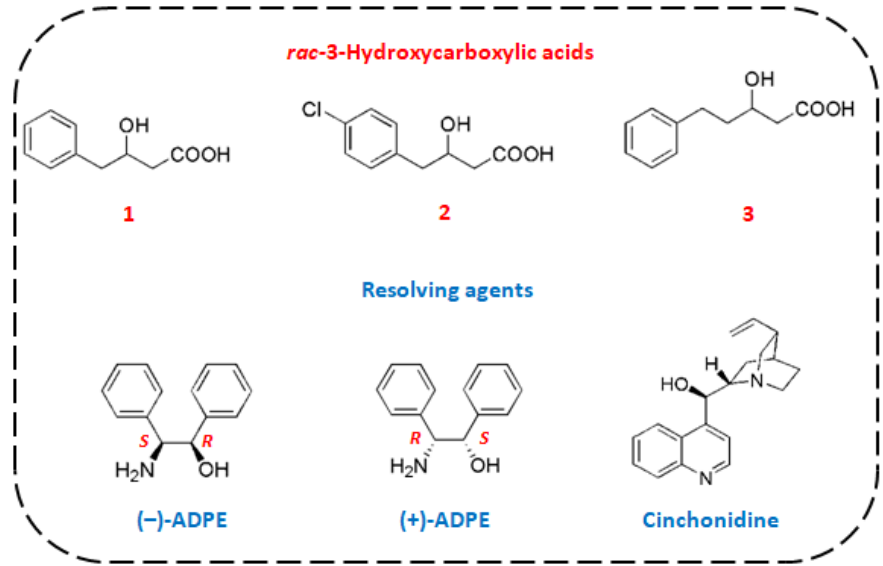
Figure 1. Chemical structures of racemic 3-hydroxycarboxylic acids and resolving agents.